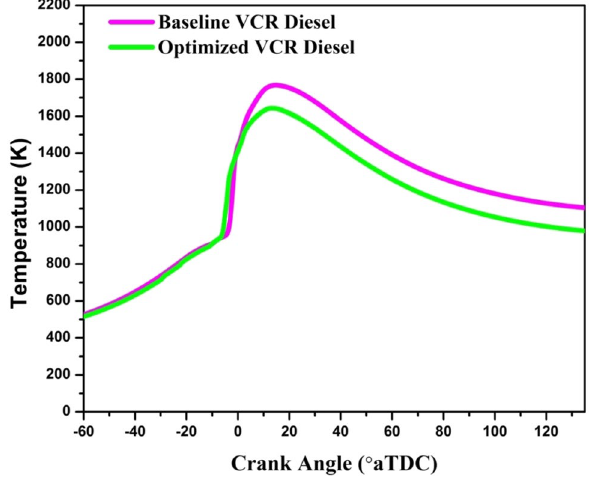
Fig. 9 Comparison of Soot versus Crank Angle for optimized and baseline (VCR